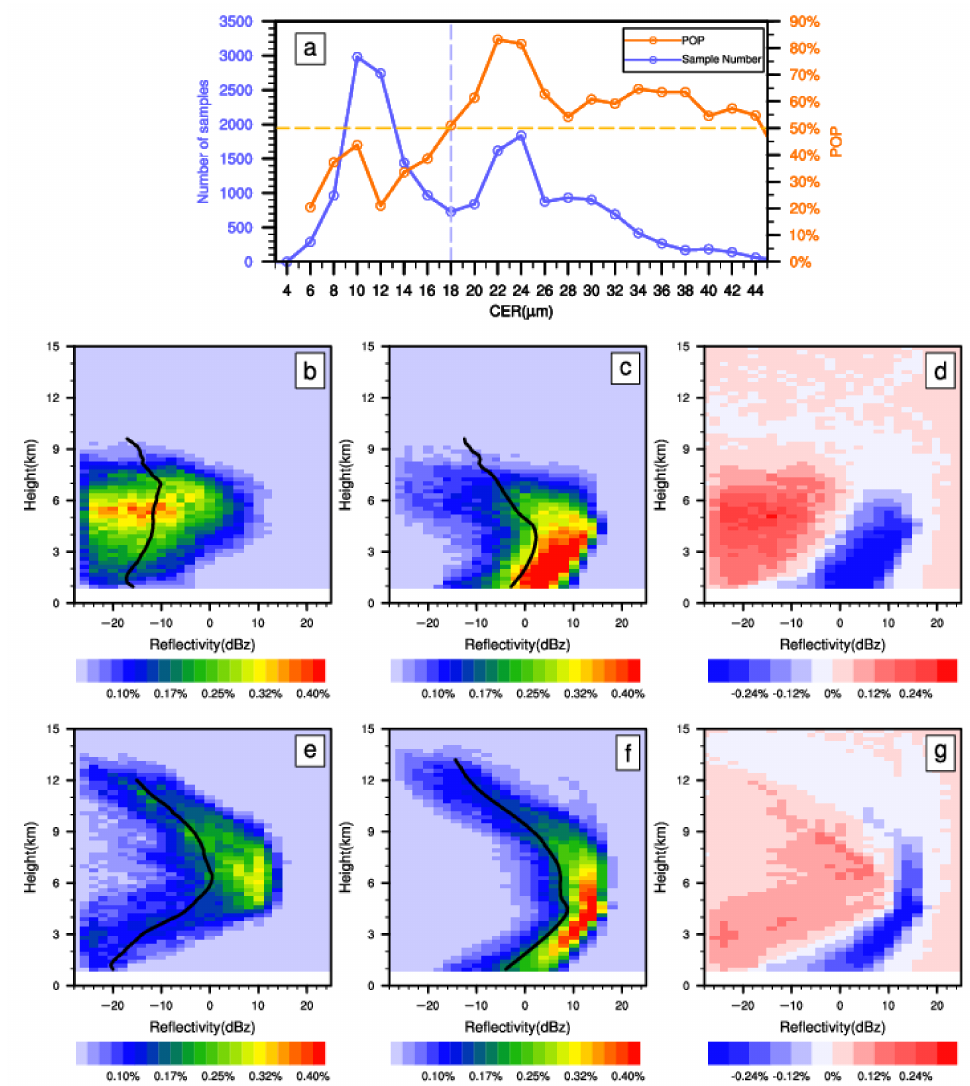
Figure 12. ( a ) Sample number (blue dotted line) and probability of precipitation (orange dotted line) as a function of cloud effective radius. Normalized contoured frequency by altitude diagrams of radar reflectivity for single-layer mixed clouds grouped by cloud effective radius values of ( b – d ) <18 µ m and ( e , f ) ≥ 18 µ m. ( b , e ) non-precipitating clouds, ( c , f ) precipitating clouds, and ( d , g ) the differences in the normalized contoured frequency by altitude diagram (non-precipitating clouds minus precipitating clouds). The black lines in parts ( b , e ) and ( c , f ) are the mean vertical profile of reflectivity for non-precipitating clouds and precipitating clouds, respectively. CER = cloud effective radius; POP = probability of